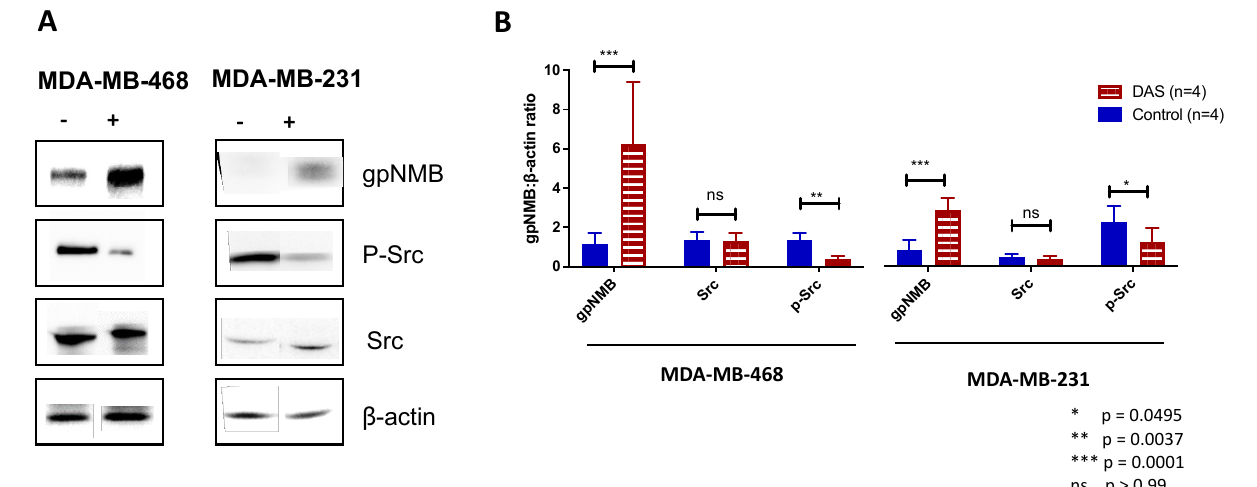
Figure 3. Dasatinib can upregulate the expression of gpNMB on MDA-MB-468 and MDA-MB-231 cells in vitro. ( A ) Western blot for gpNMB, β -actin, and dasatinib-related proteins p-Src, Src; ( B ) Normalized gpNMB expression relative to β -actin. DAS = dasatinib.